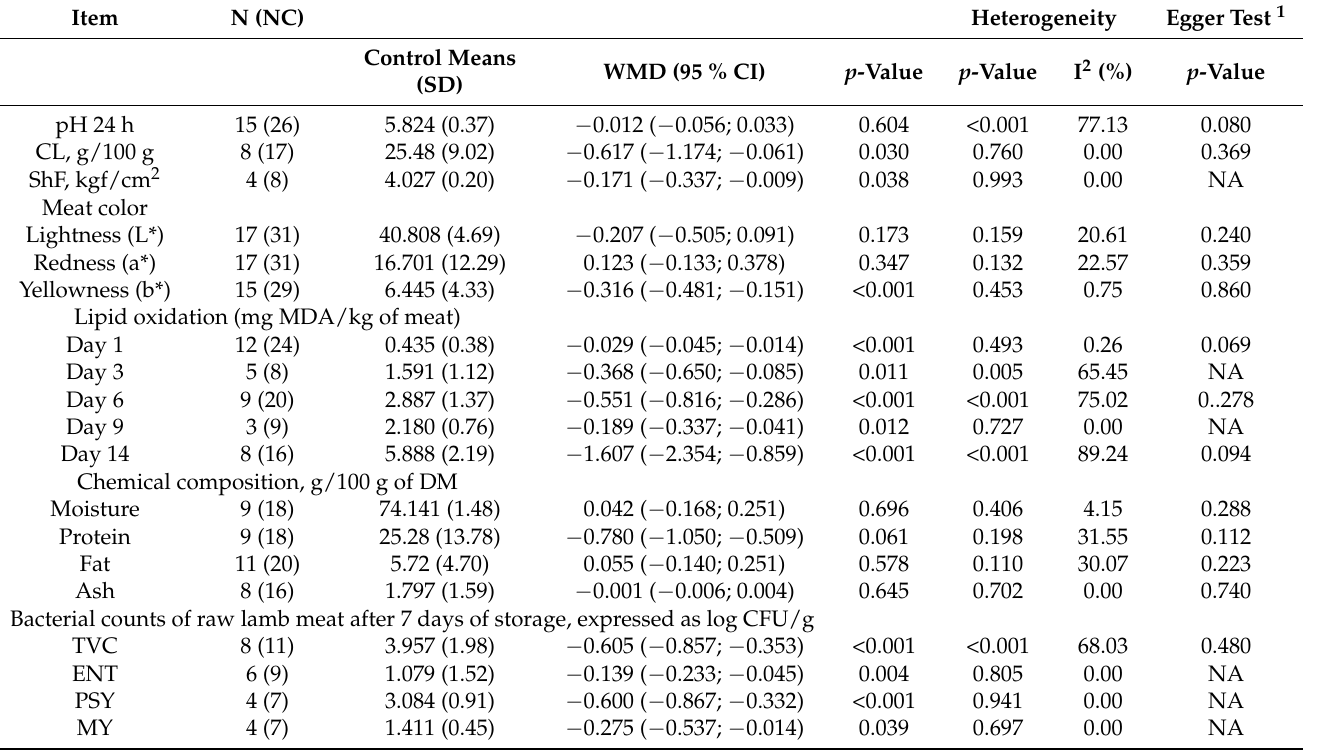
Table 6. Meat quality of small ruminants supplemented with essential